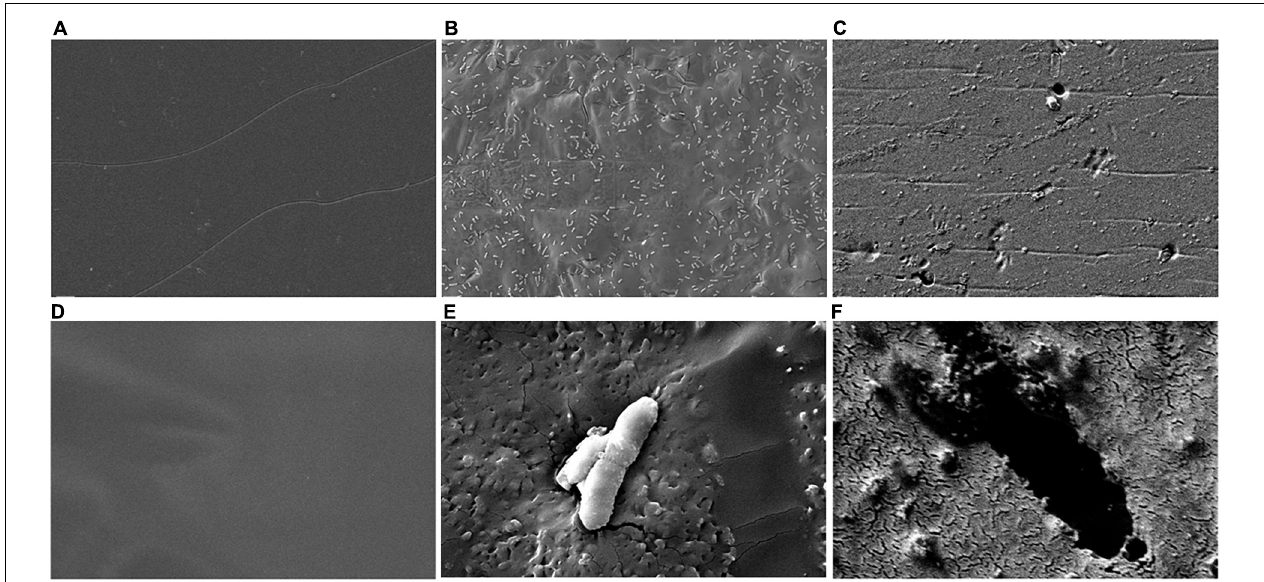
FIGURE 6 | Scanning electron microscopy (SEM) shows PLA fracturing around B. pumilus B12 cells. (A–C) 5,000 × magnification of 10 mg/mL of PLA film for 48 h with: media only (A) , B. pumilus B12 (B) , and Proteinase K (C) . (D–F) 30,000 × magnification of 10 mg/mL PLA films with: media only (D) , B. pumilus B12 (E) , and Proteinase K (F) .